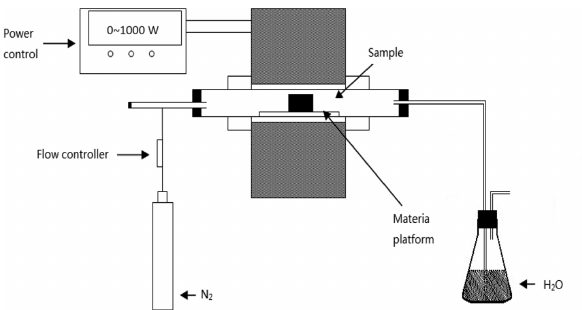
Figure 1: Schematic of microwave heating furnace.